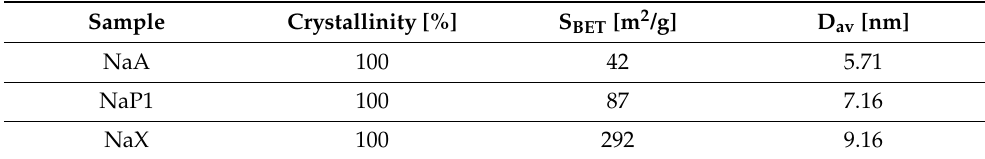
Figure 12. Pore size distribution for samples obtained under optimal conditions. Table 3. Crystallinity, specific surface area (S BET ), and average pore sizes (D av ) for samples obtained under optimal